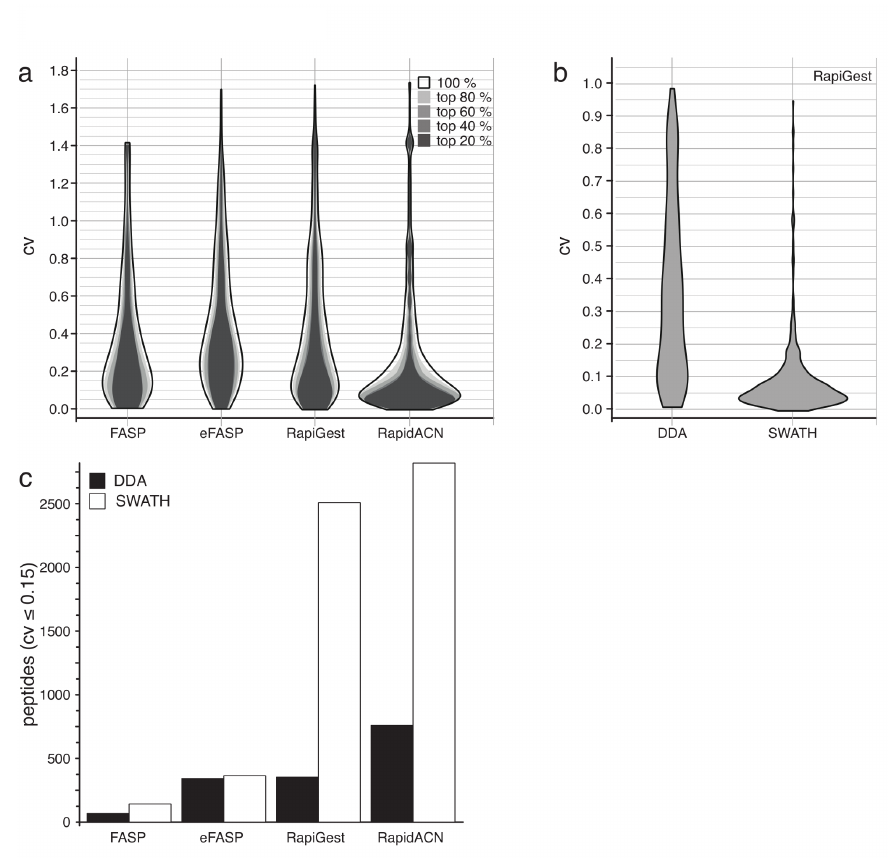
Figure 4. In solution digestion leads to stable results in label-free proteomics. ( a ) The distribution maximum of coefficients of variation (CV) of the selected protocols varies between 0.075 and 0.2. CV values obtained for protocol triplicates are shown as two-dimensional distribution histograms (‘violin plots’). Quantification in DDA experiments was consistent over the dynamic range, as CV values only marginally changed when filtering by peptides according to their abundance (80%, 60%, 40% or 20%). CV likelihood maxima of all protocols were below 20%, while RapidACN led to the most reproducible results (CV = 7%) (n = 3). ( b ) Stability in a quantification experiment is improved by data-independent acquisition. CV values for the same set of peptides measured with SWATH and DDA using the RapiGest protocol, as shown in a two-dimensional distribution histogram. Whereas there was a high signal variation in DDA acquisition, the variation could be largely reduced in SWATH acquisition. ( c ) In solution protocols yield the highest number of peptides suitable for label-free quantification. The number of peptides with a CV < 0.15 as determined in DDA and SWATH acquisitions. The number of highly reproducible peptides was lower for FASP and eFASP, and SWATH acquisition did not improve the performance in combination with these methods. In solution protocols on the other hand did yield a maximum of about 2500 high-quality peptides using